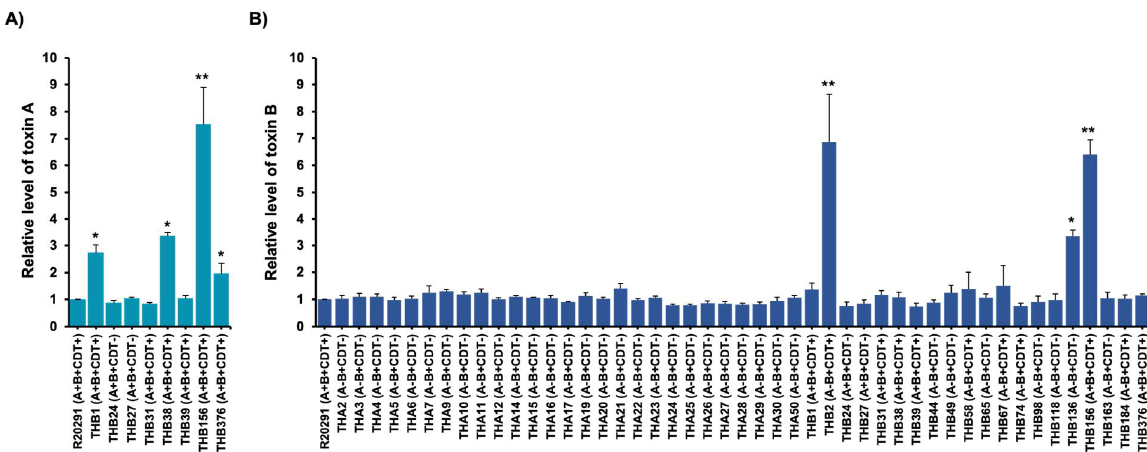
Figure 3. The relative level of toxin A and B production of C. difficile isolates. Toxigenic C. difficile isolates in the THA group; B + (n = 27) and the THB group; A + (n = 8) and B + (n = 20) were subjected to indirect ELISA. ( A ) The light blue bars represent toxin A, and ( B ) the dark blue bars represent toxin B. The graph shows average values of 3 independent samples in the experiments. Error bars refer to mean ± SEM, p < 0.05, *, and p < 0.01, **.